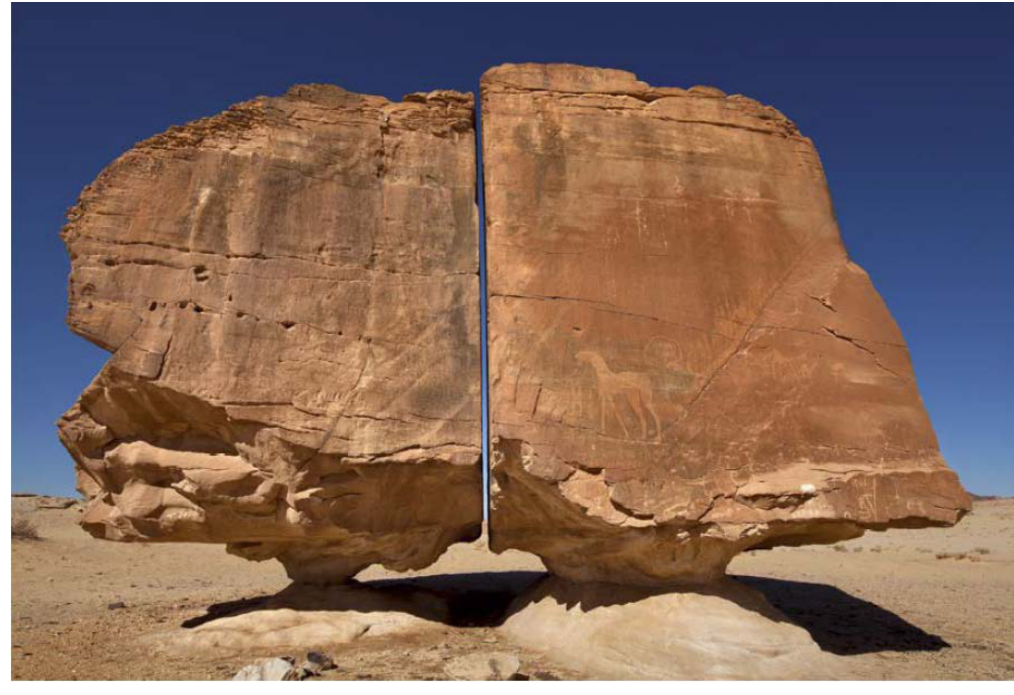
Figure 35. The incredible split rock near